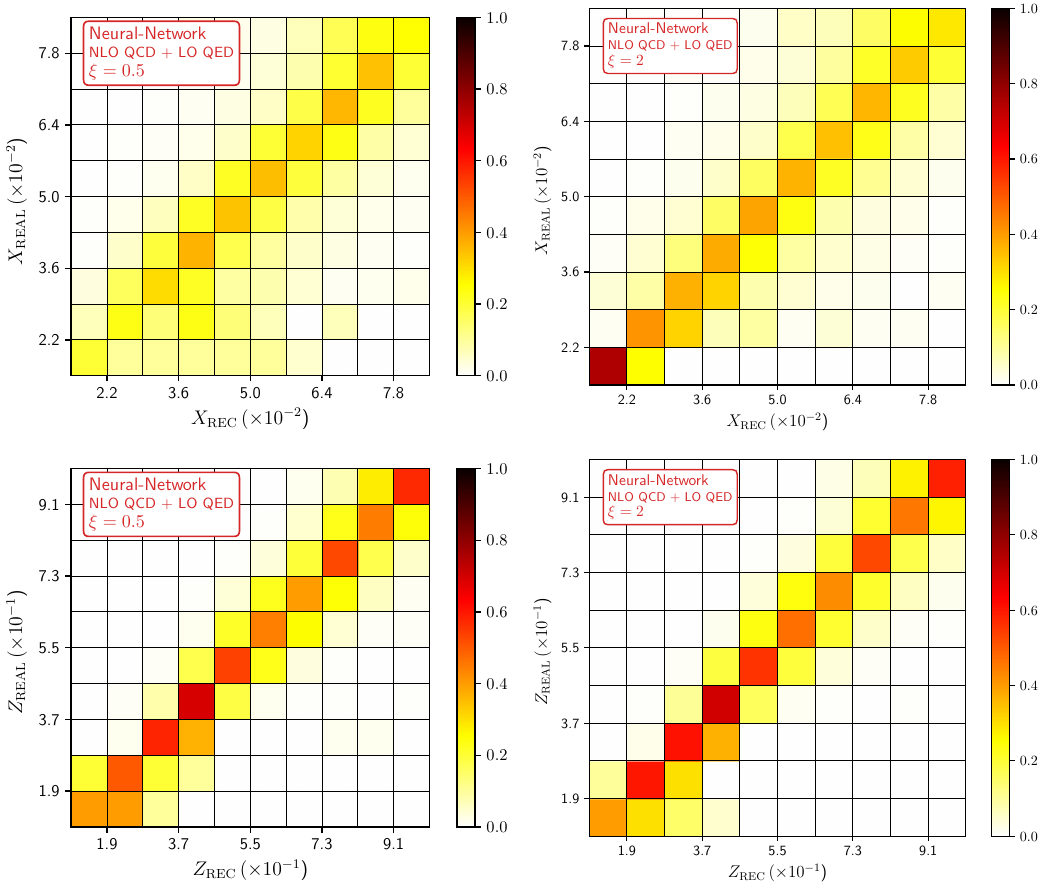
Figure 19: First row: Comparison of the momentum fractions X tained with MLP neural networks (using the parameters given in Table 2) for differ- ent renormalization / factorization scales, µ the left (right) plot. Second row: same as in the first row, but for Z